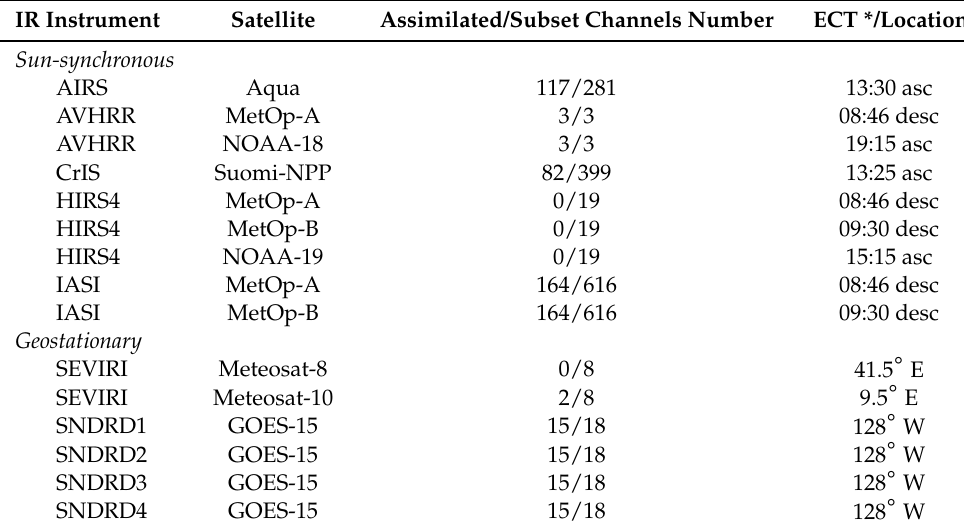
Table 1. The information of thermal infrared sensors ingested into GDAS. IR Instrument Satellite Assimilated/Subset Channels